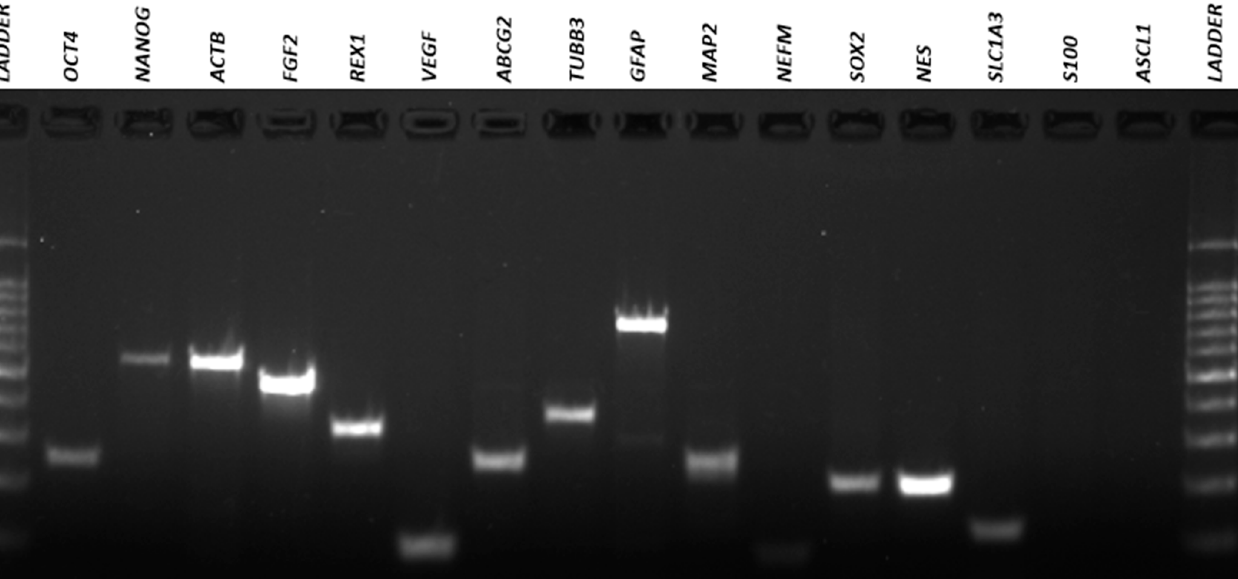
Figure 8. NPs electrophoresis gel. RT-PCR for amplification of OCT4 (292 bp), NANOG (578 bp), ACTB (564 bp), FGF2 (482 bp), REX1 (344 bp), VEGF (107 bp), ABCG2 (270 bp), TUBB3 (385 bp), GFAP (789bp), MAP2 (241bp), NEFM (98bp), SOX2 (224bp), NES (220bp), SLC1A3 (136bp), S100 (261bp) and ASCL1 (122bp) genes in NPs. NPs, neural precursors.